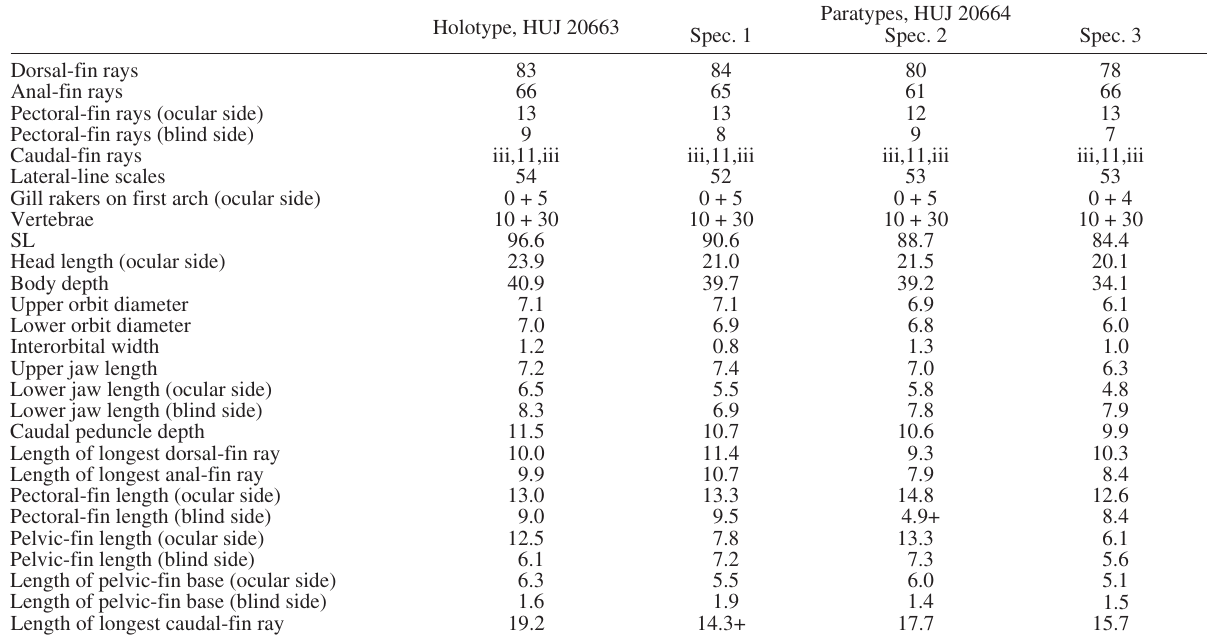
2. – Arnoglossus nigrofilamentosus n. sp., HUJ 20663, holotype, 96.6 mm SL, Jaffa, Israel. Sketch of ocular side of preserved Table 2. – Counts and measurements [mm] of Arnoglossus nigrofilamentosus n. sp., HUJ 20663 (holotype, 96.6 mm SL), and HUJ 20664 (3 paratypes, 84.4-90.6 mm SL), Israel, Jaffa, eastern Mediterranean Sea.